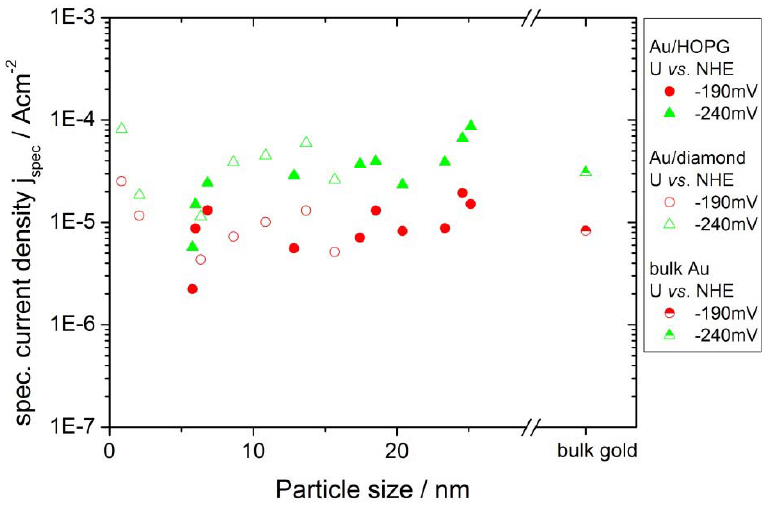
Figure 9. Comparison of the HER specific current density for Au/HOPG (filled symbols) and Au/diamond (open symbols). The current densities versus particle size are comparable for the two substrates. The data for an extended gold surface was added as a reference. For the sake of clarity, only two potentials are